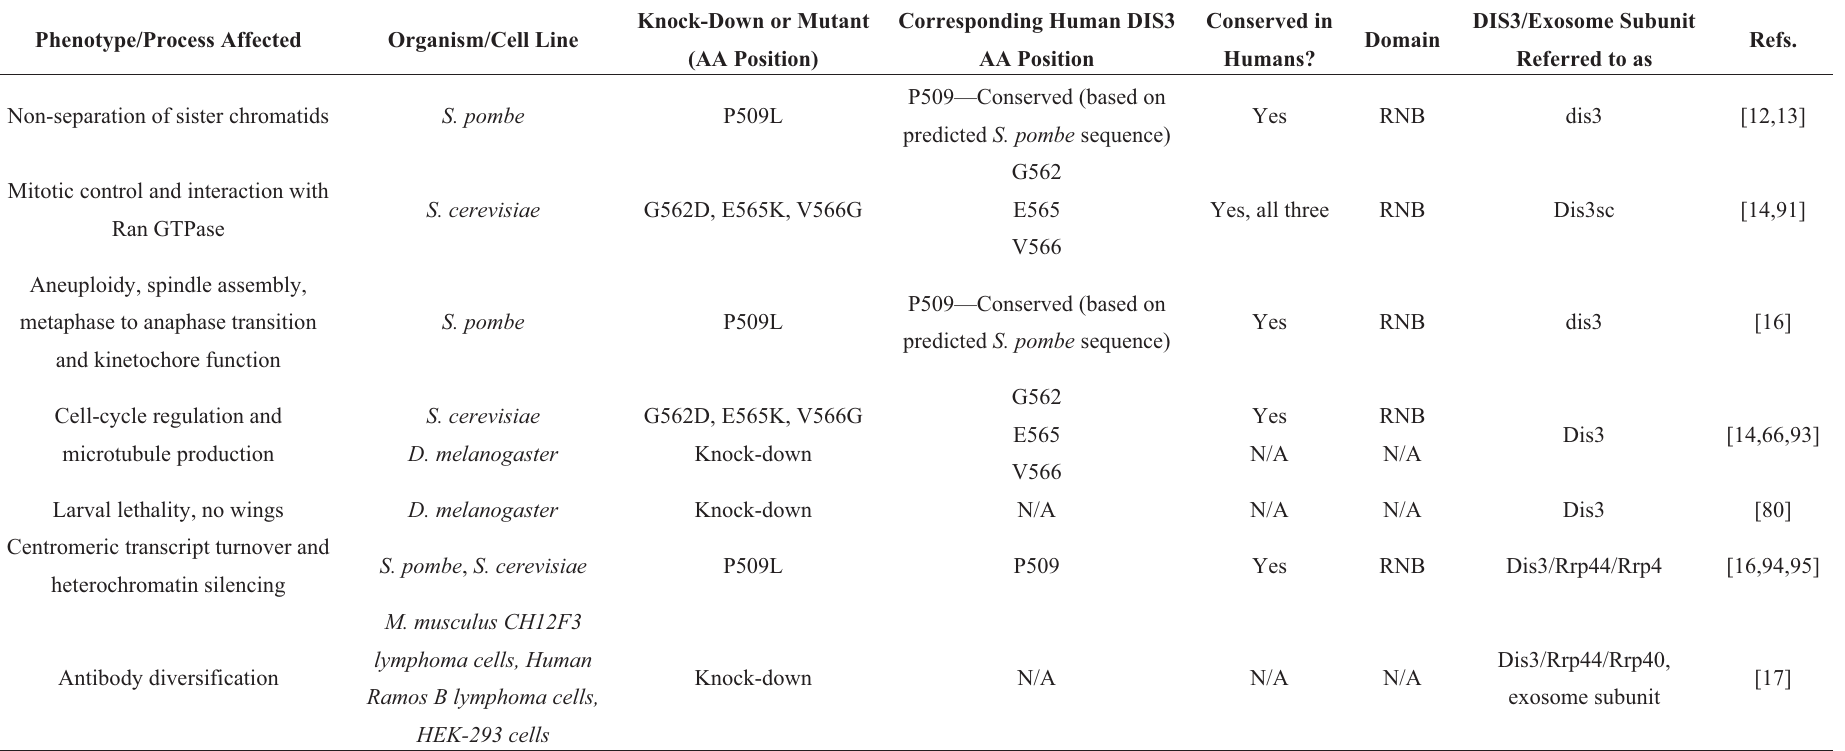
Table 1. List of phenotypes observed in DIS3/exosome mutants and knock-downs in various organisms. Where applicable the corresponding amino acid (AA) in human DIS3 has been given, along with the affected